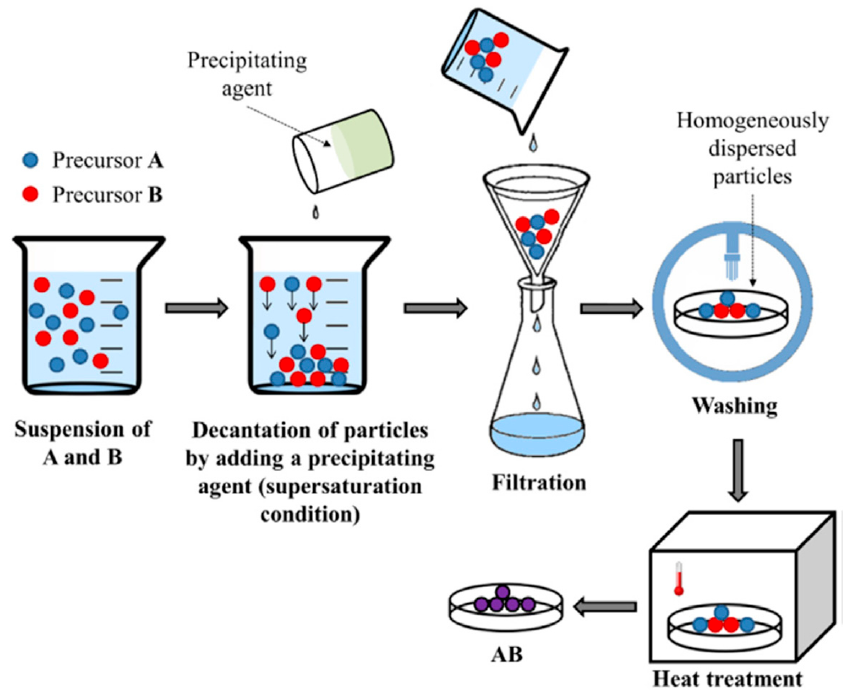
Figure 12. General schematic of the co-precipitation method (Reprinted with permission from [42]). Table 3. Members of the LaAlO 3 perovskite family recently synthetized using different methods.